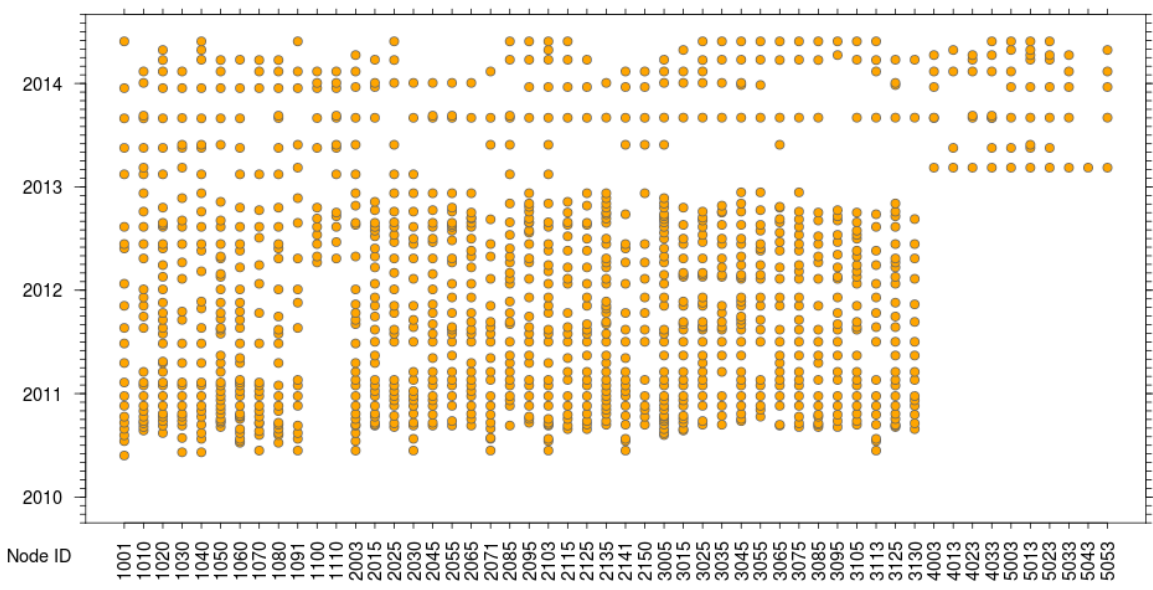
Figure 16. Battery changing schedule from initial network deployment until the end of April 2014. For each node in the network, days when a node’s batteries were changed are indicated by an orange dot.